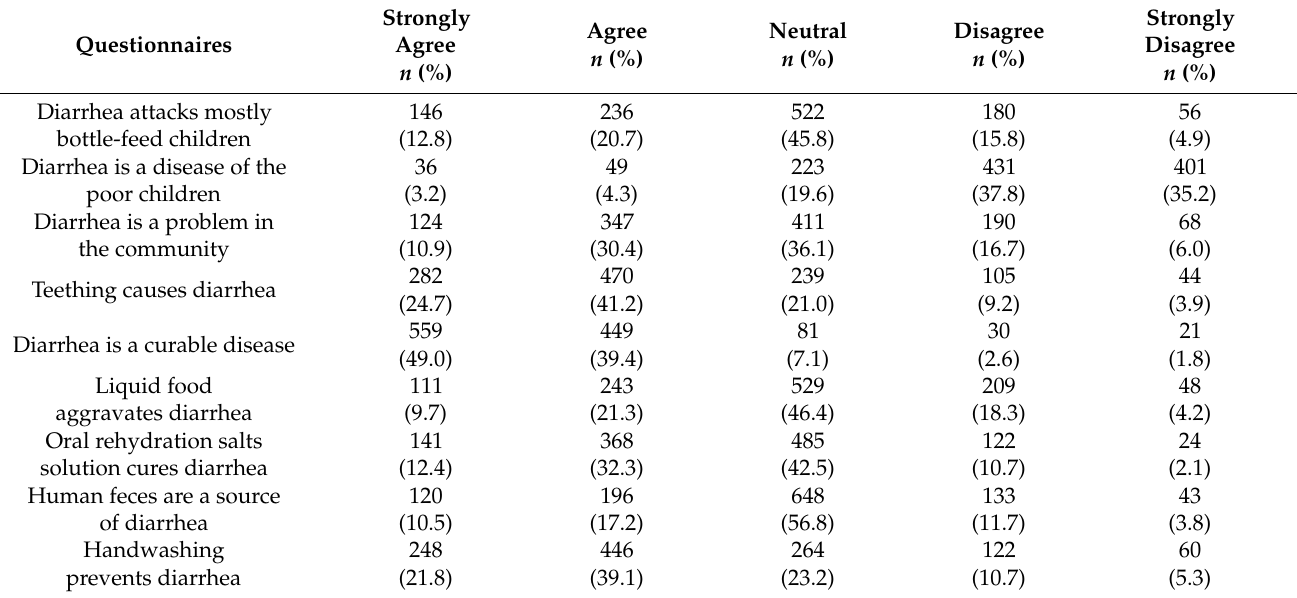
Table 4. Mothers’ attitude about childhood